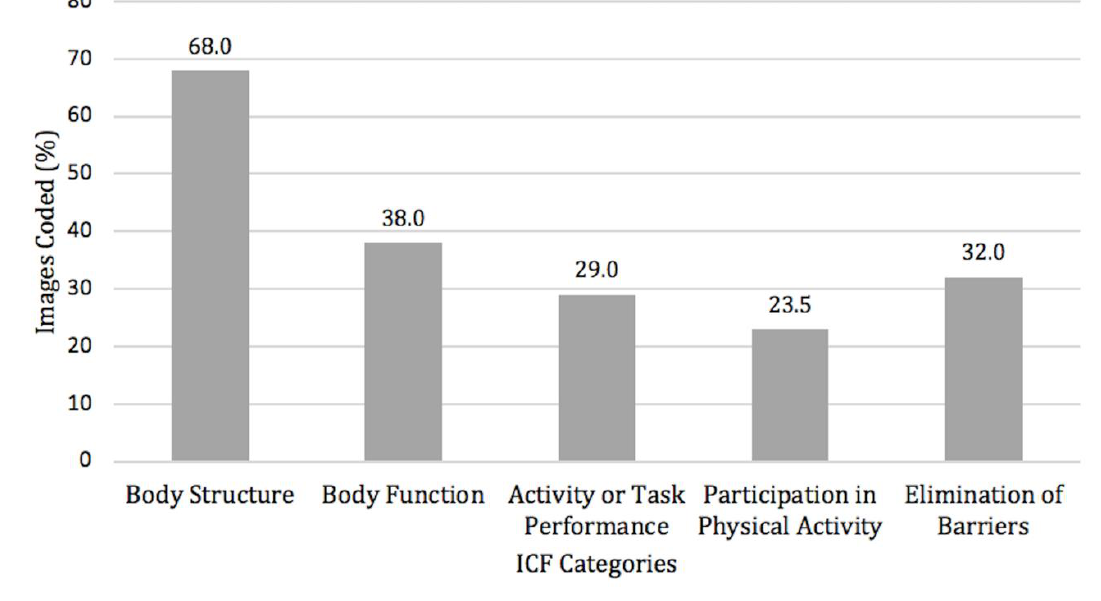
Figure 3. Percent of images coded for each International Classification of Functioning, Health and Disability (ICF)